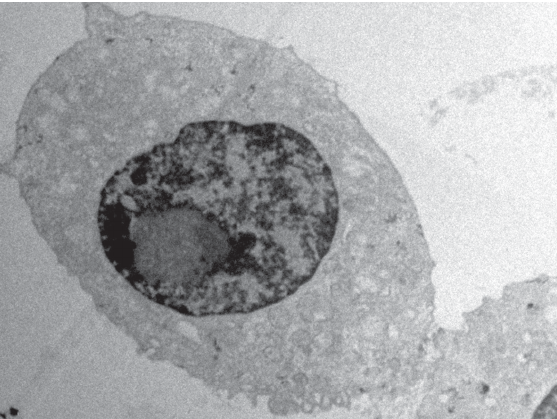
Fig. 2. Electron micrographs of BMSC-AS cells differentiated into osteogenic